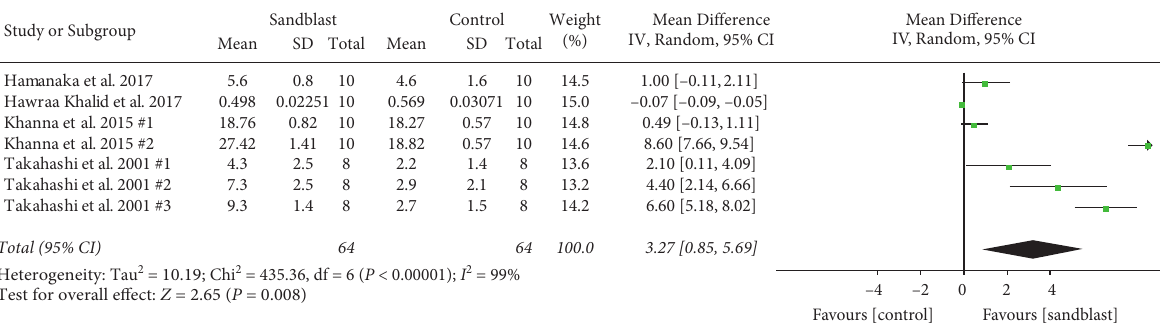
Figure 3: Forest plot for global analysis of shear bond strength.